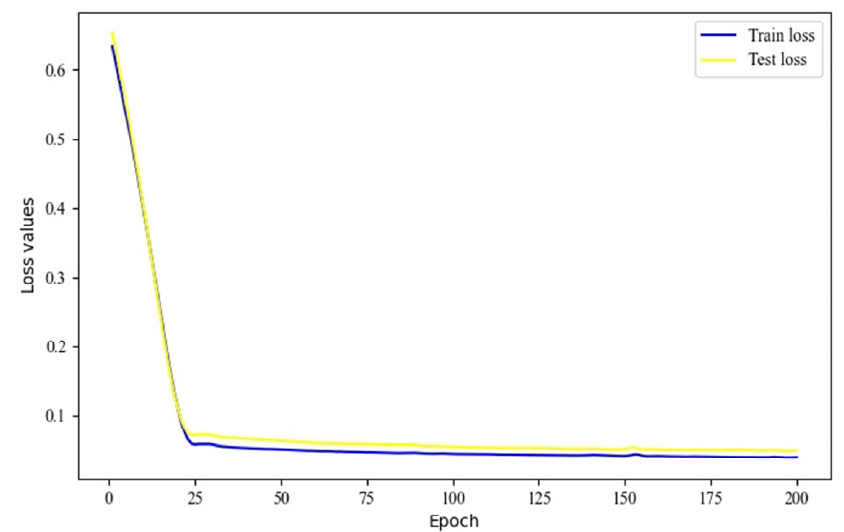
Figure 6. Convergence of loss function of reducer transmission accuracy error.